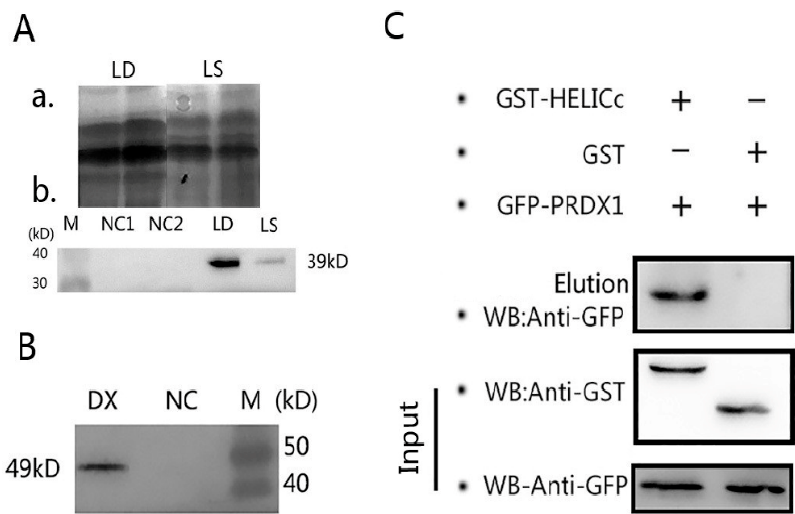
Figure 8. ( A ) GST Pull-Down assay of HELICc and PRDX1. Sodium dodecyl sulfate-polyacrylamide gel electrophoresis (SDS-PAGE) results of GST-tagged recombinant protein GST-HELICc in inclusion body protein (LD) and soluble protein (LS; a) and western blot analysis of GST-HELICc protein in inclusion body protein and soluble protein (b). ( B ) Western blot analysis of GFP-tagged recombinant protein GFP-PRDX1 (DX). ( C ) Verification of interaction between HELICc and PRDX1 by GST Pull-Down assay. Input, anti-GFP; GFP-PRDX1 using GFP-tagged mouse mAb; Anti-GST, GST-HELICc, and GST using GST-tagged mouse mAb; Elution, using both GFP and GST-tagged mAb.